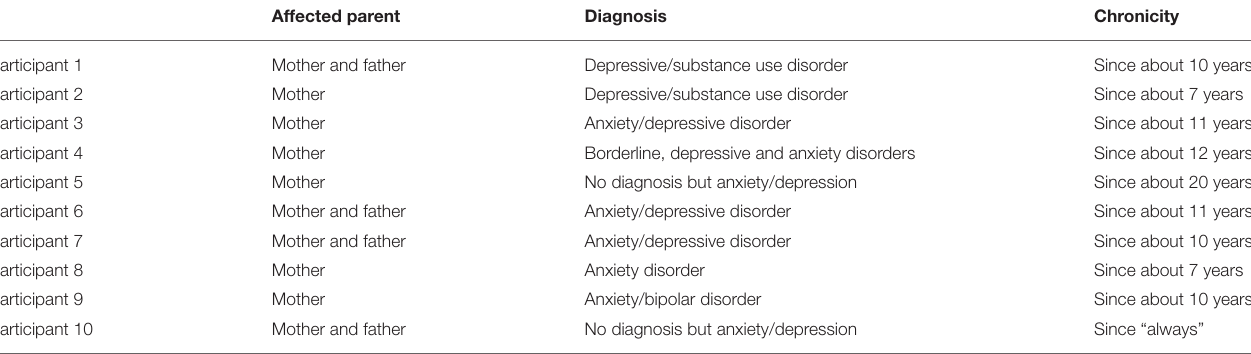
TABLE 1 | Family characteristics of